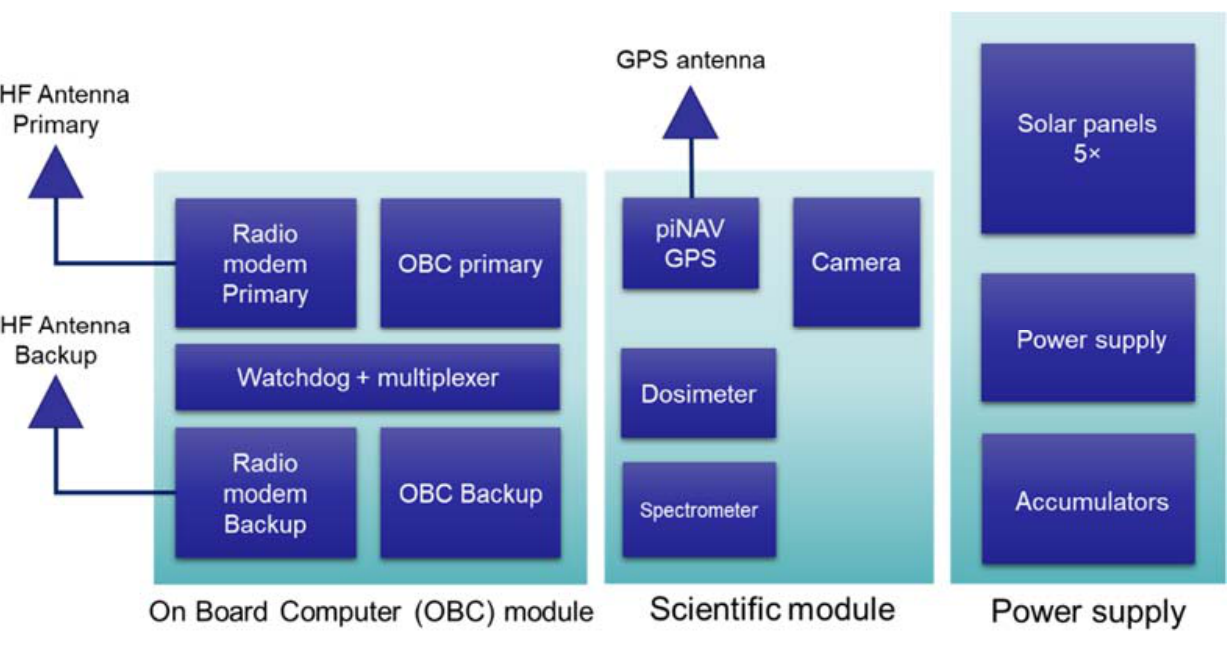
Figure 2. Block scheme of Lucky 7.